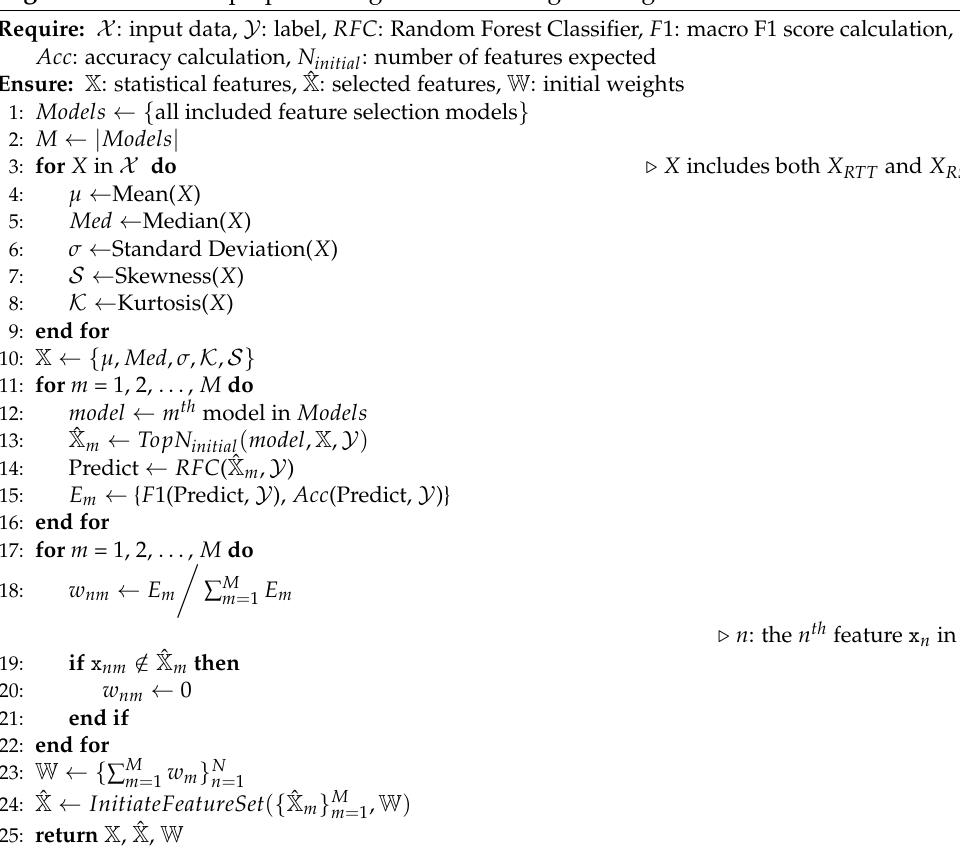
Algorithm 1 Feature preprocessing and initial weights